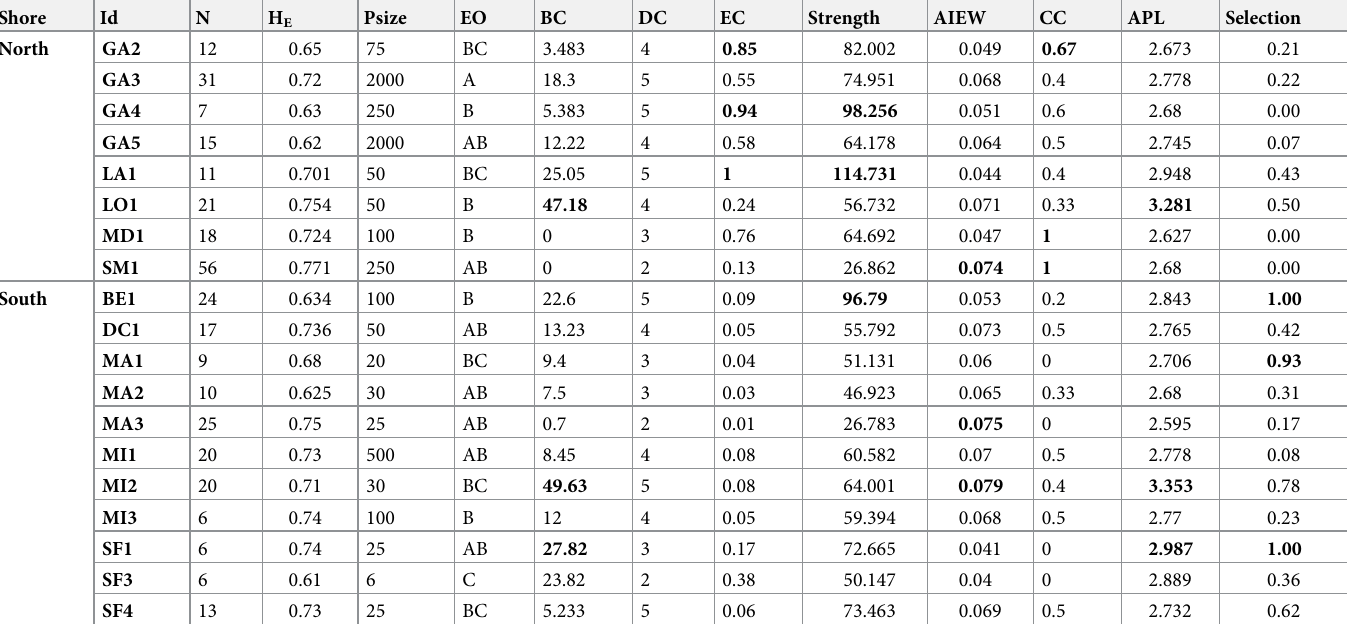
Table 1. Sampled population parameters and corresponding node-based metrics, node removal statistics and BRIDES results.